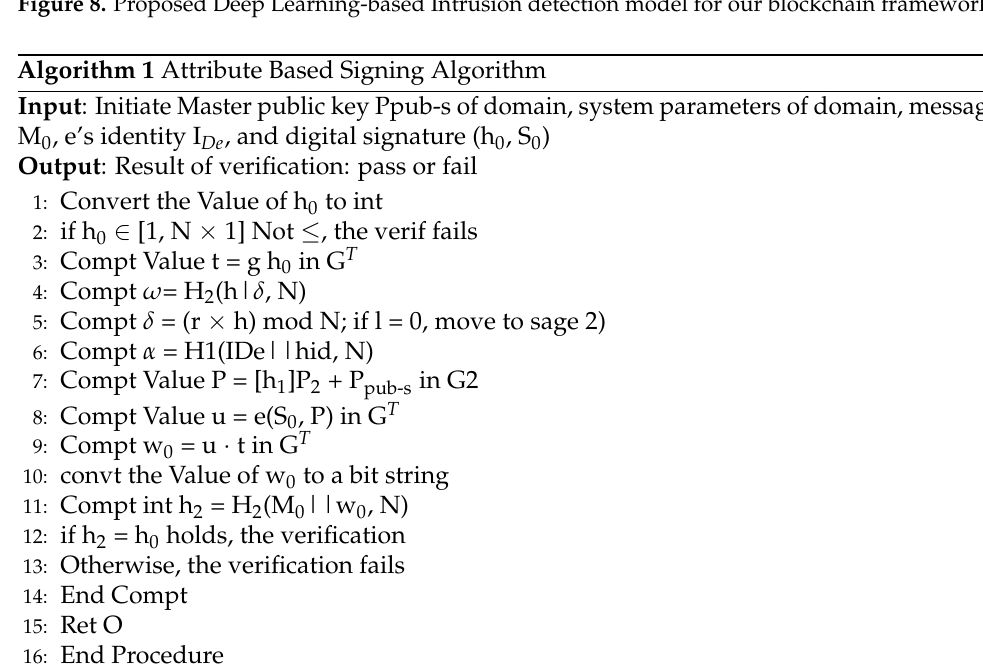
Figure 8. Proposed Deep Learning-based Intrusion detection model for our blockchain